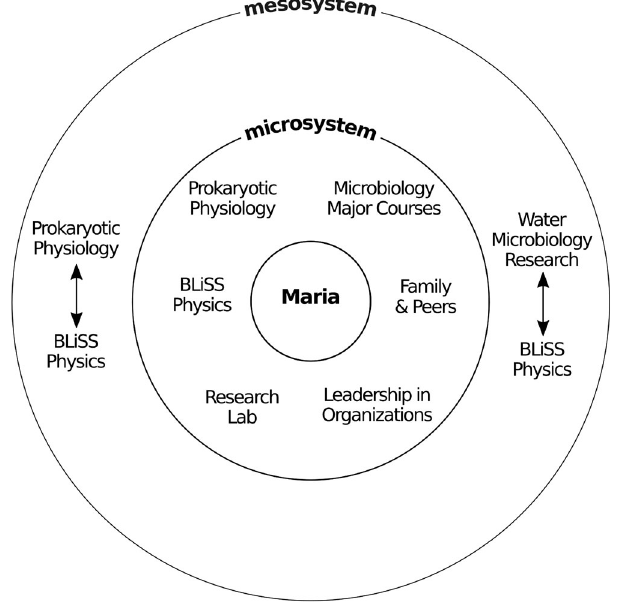
FIG. 4. Maria ’ s microsystem and mesosystem. While the whole of Maria ’ s experiences can never be captured in any diagram, this figure represents areas of Maria ’ s life that we consider important to exploring the relevance of physics to